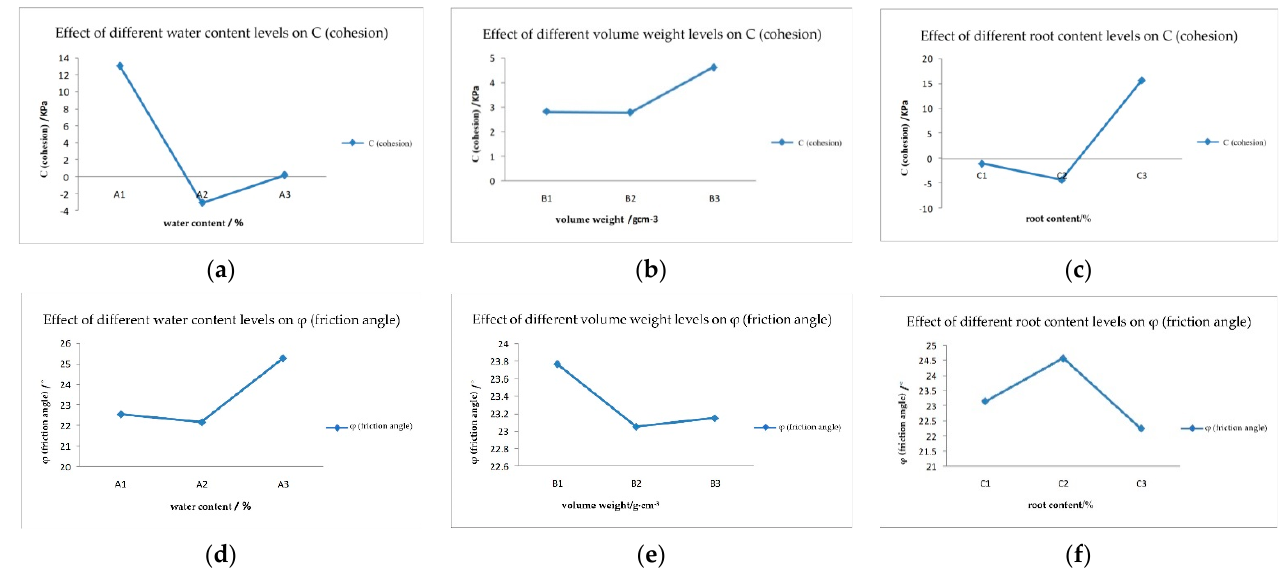
Figure 3. Trend diagram of test factors and indexes. Note: ( a ) the effect of water content on cohesion. ( b ) the effect of volume weight on cohesion. ( c ) the effect of root content on cohesion. ( d ) the effect of water content on friction angle. ( e ) the effect of volume weight on friction angle. ( f ) the effect of root content on friction angle.